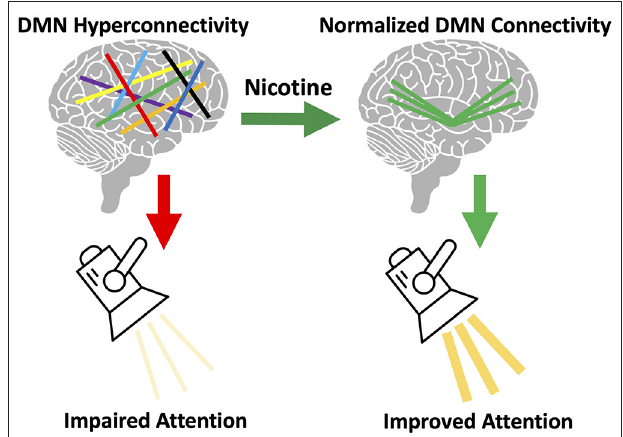
FIGURE 6 | Proposed model of brain circuitry driving nicotine use in schizophrenia. We observed default mode network (DMN) hyperconnectivity in our sample of individuals with schizophrenia, consistent with prior literature (33). We also observed that acute nicotine administration normalized DMN hyperconnectivity in schizophrenia. Based on this data, we hypothesize that individual variation in the magnitude of this DMN disruption gives rise to: (a) variation in the severity of network disorganization and (b) variation in severity of nicotine use. We propose that the DMN mediates the relationship between nicotine use and cognition in schizophrenia. DMN hyperconnectivity is linked to poor attentional performance (45) and, in healthy controls, nicotine can both reduce DMN connectivity and improve attention ( 11). We propose that DMN connectivity mediates the relationship between nicotine use and attentional performance and that disruption of this network in schizophrenia drives the need for nicotine to correct network pathology (and